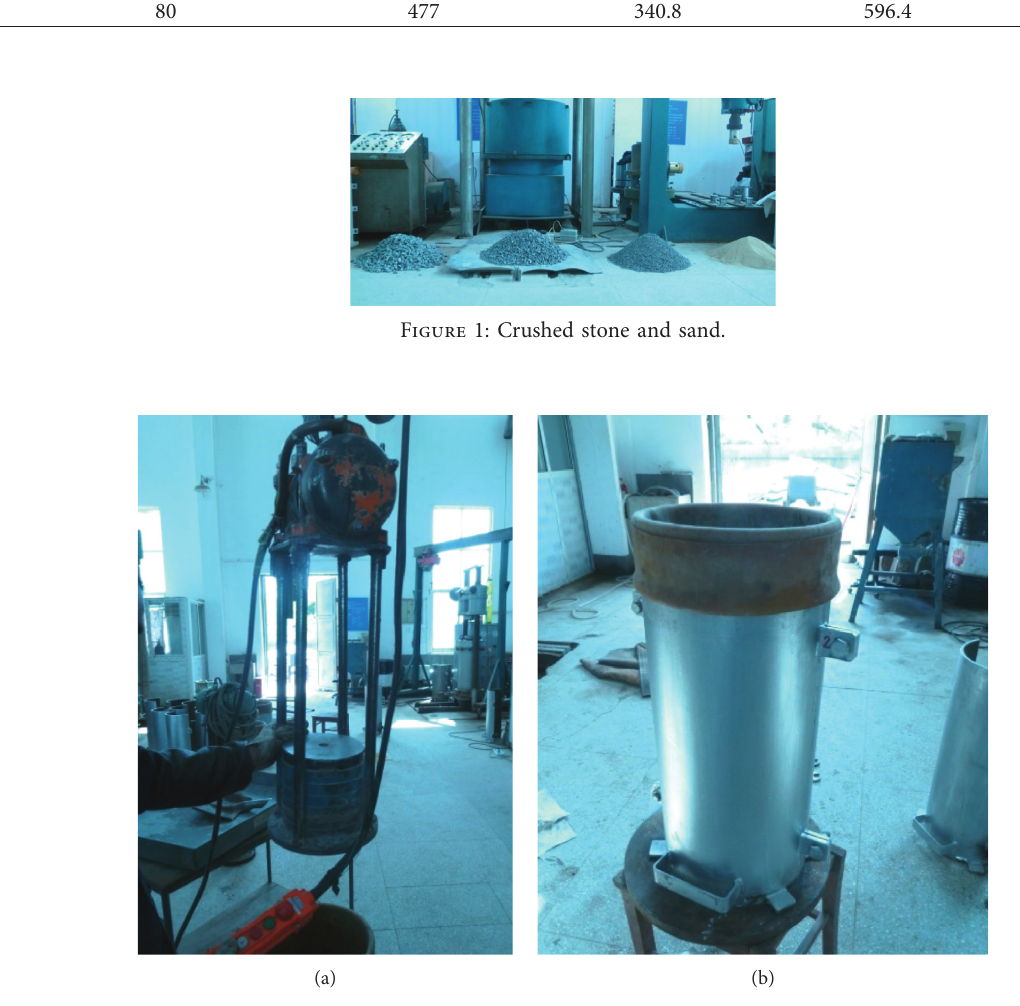
Figure 2: Equipment for specimen preparation. (a) High-frequency vibration roller. (b) Ductile iron